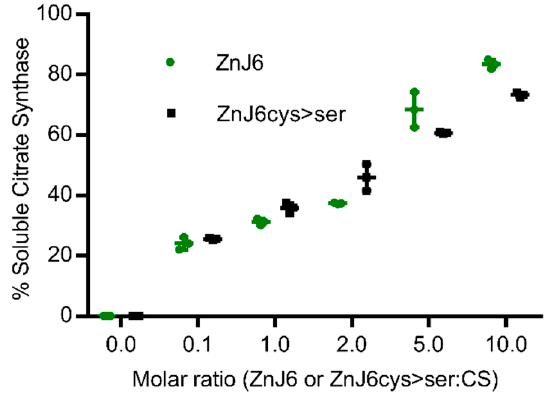
Figure 4. ZnJ6 and its ZnJ6cys > Ser-mutant have holding chaperone activity measured by the citrate synthase thermal aggregation assay. Citrate synthase (CS) was diluted into a refolding mixture at 42 °C (1 h) or into a refolding mixture with ZnJ6 (green circles). A parallel assay was performed with the ZnJ6cys > Ser-mutant (black squares). All assays were performed in the presence of increasing molar ratios relative to CS (ZnJ6: CS; 0:1, 0.1:1, 1:1, 2:1, 5:1, 10:1). The thermal aggregation of CS was measured by monitoring OD 360 over time. The absorbance was used to calculate the percentage of soluble CS after 1 h of incubation at elevated temperatures. CS that was not subjected to increased temperature served as the 100% soluble control. CS alone incubated at 42 °C for 1 h served as the fully aggregated substrate. The t -test was used for statistical analysis, and the error bars show the standard deviation. This analysis showed that there is no significant difference between the holding chaperone activity of ZnJ6 and ZnJ6cys > Ser-mutant protein. The values show the mean of triplicate experiments.